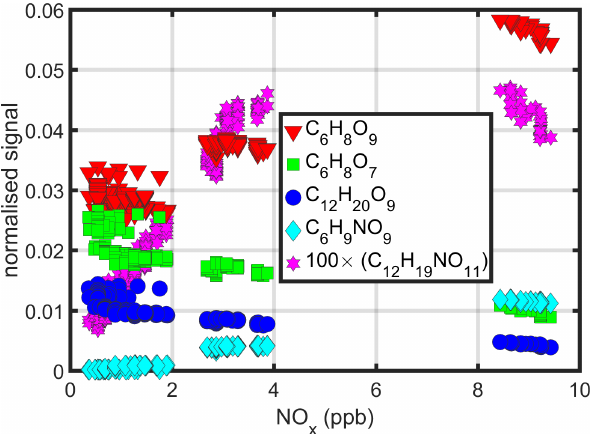
Figure 2. Examples of signal changes due to increased NO x lev- els in the chamber. Shown are examples of two differently behav- ing monomers and a dimer without nitrogen, as well as a nitrogen- containing monomer and dimer. The last one had a signal so small that in the figure it is multiplied by a factor of 100. No measure- ments were done with NO x concentrations between 4 and 8ppb.